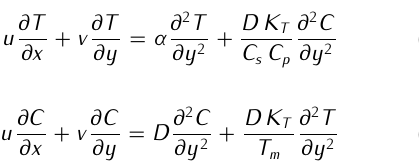
Figure 12. Effect of Schmidt number Sc on Heat Transfer